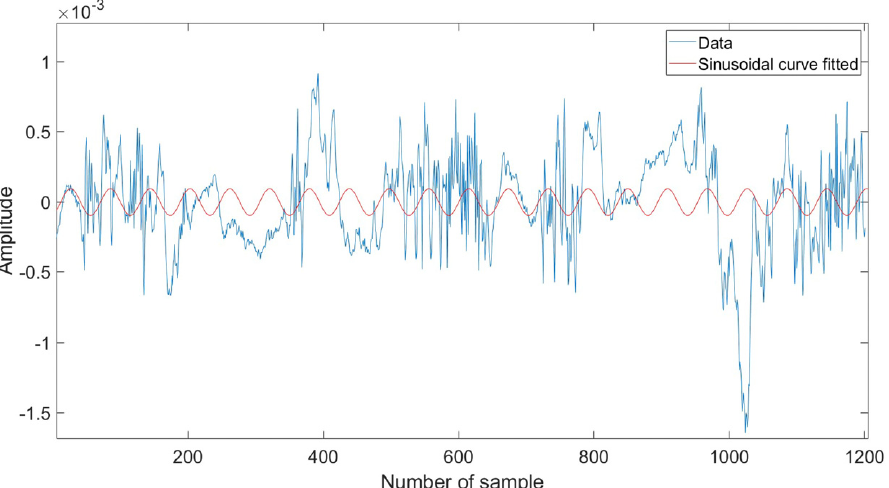
Figure 5. Sample of signal with sine curve fit below threshold value.